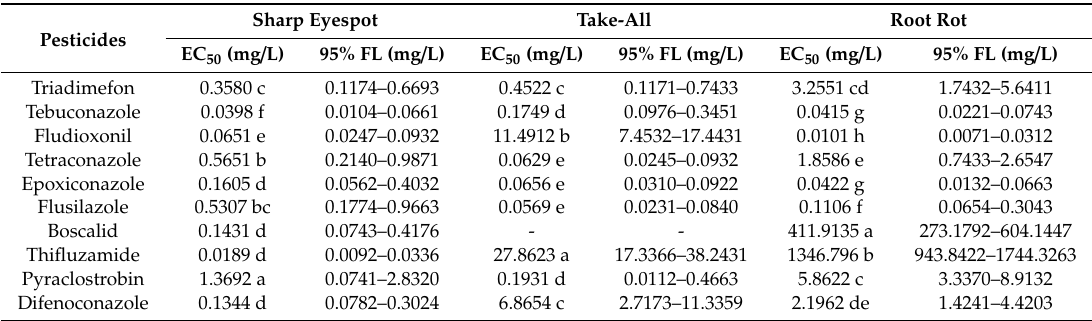
Table 1. Half-maximal e ff ective concentration (EC50) of 8 fungicides against the three soil-borne diseases control in